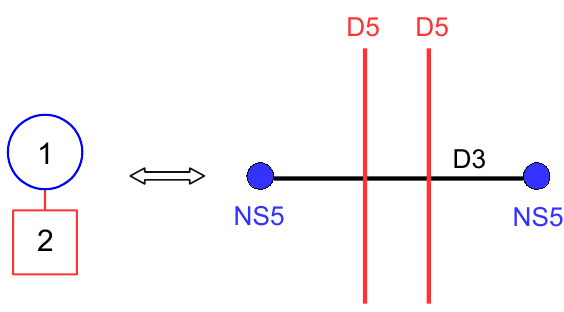
Figure 4 . Quiver and brane con(cid:12)guration for the T [SU(2)]